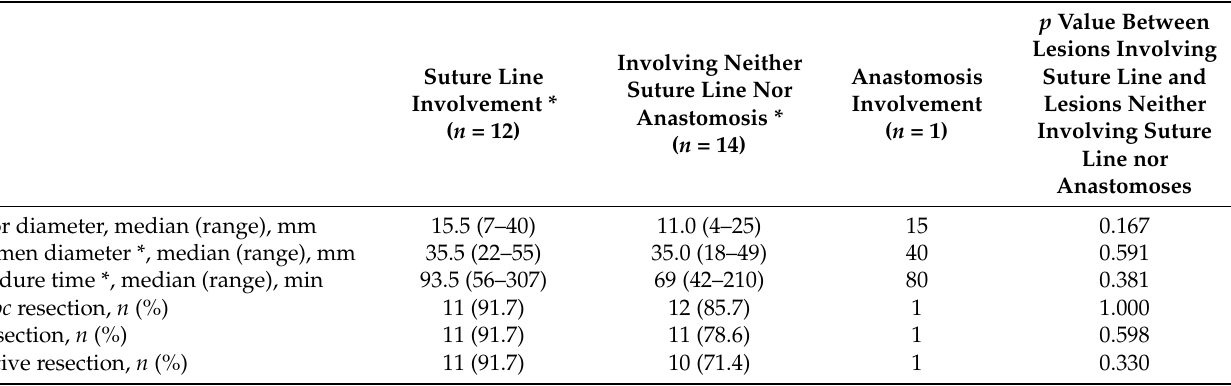
Table 4. Comparison of the treatment outcomes of endoscopic submucosal dissection according to suture line or anastomosis